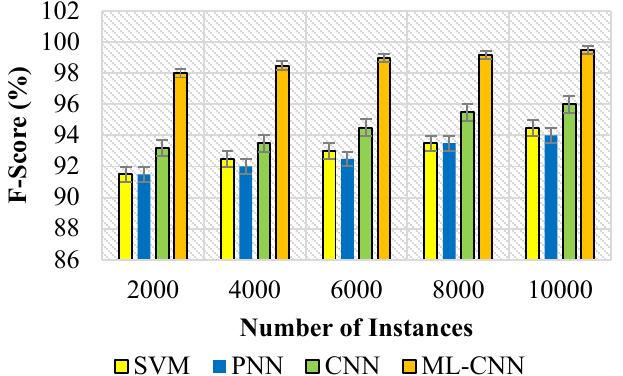
Figure 11. F‑score vs. number of Figure 11. F-score vs. number of instances . Figure 11. F-score vs. number of instances . Figure 11. F-score vs. number of instances .